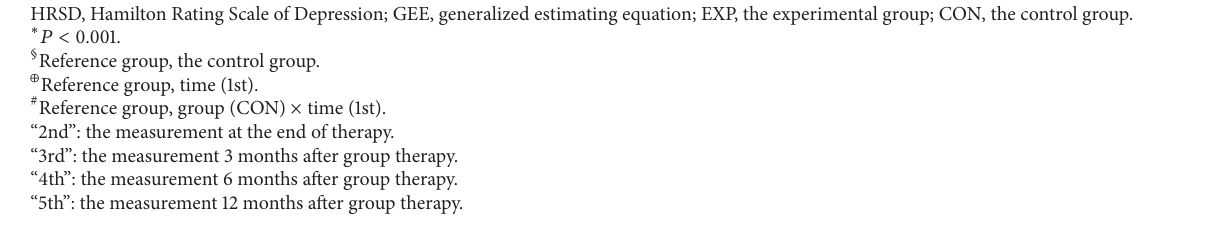
Table 5: GEE analysis of ATQ